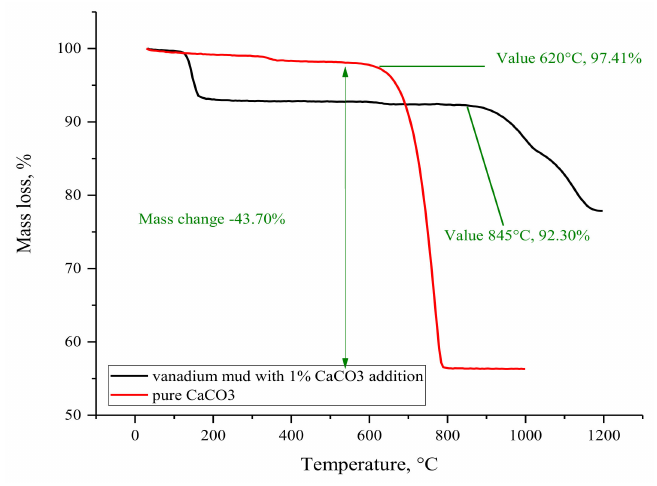
Figure 6. TG curves of the vanadium sludge with 1% CaCO 3 additive and pure CaCO